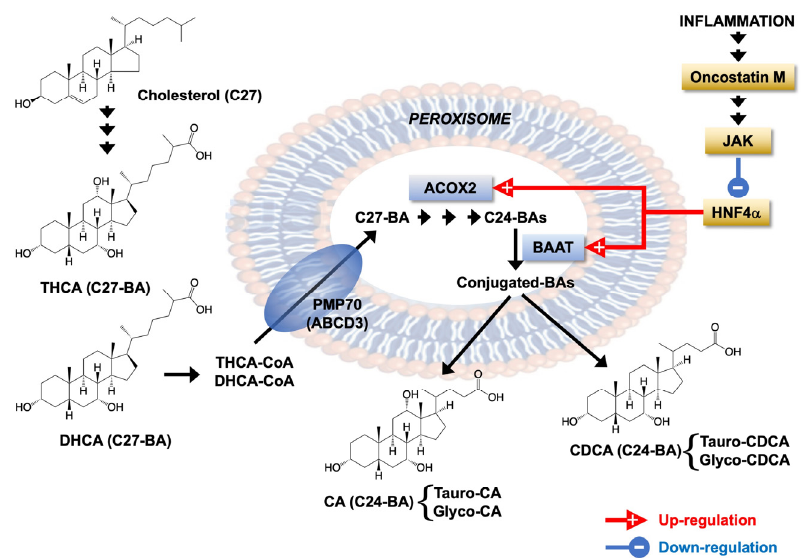
Figure 9. Schematic representation of the effect of inflammation-associated cytokines oncostatin M, IL6, IL1 β and TNF α on the expression of peroxisomal enzymes acyl-CoA oxidase 2 (ACOX2) and BA-CoA:amino acid N-acyltransferase (BAAT) involved in bile acid (BA) side chain shortening and conjugation with taurine or glycine, respectively. PMP70, 70-kDa peroxisomal membrane protein or ABCD3 transporter; CA, cholic acid; CDCA, chenodeoxycholic acid; DHCA, dihydroxycholestanoic acid; THCA, trihydroxycholestanoic acid.